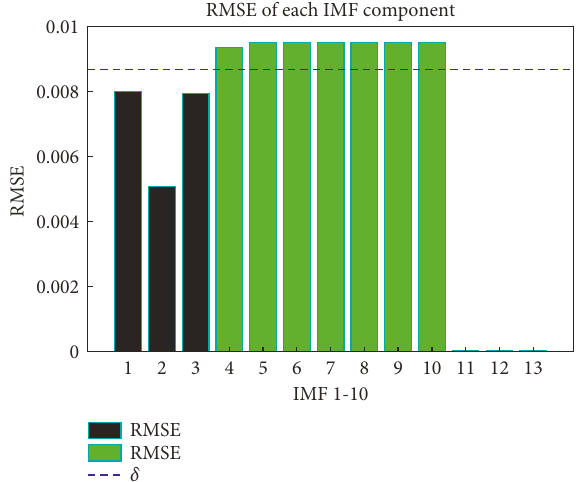
Figure 10: Root mean square error of each IMF component.